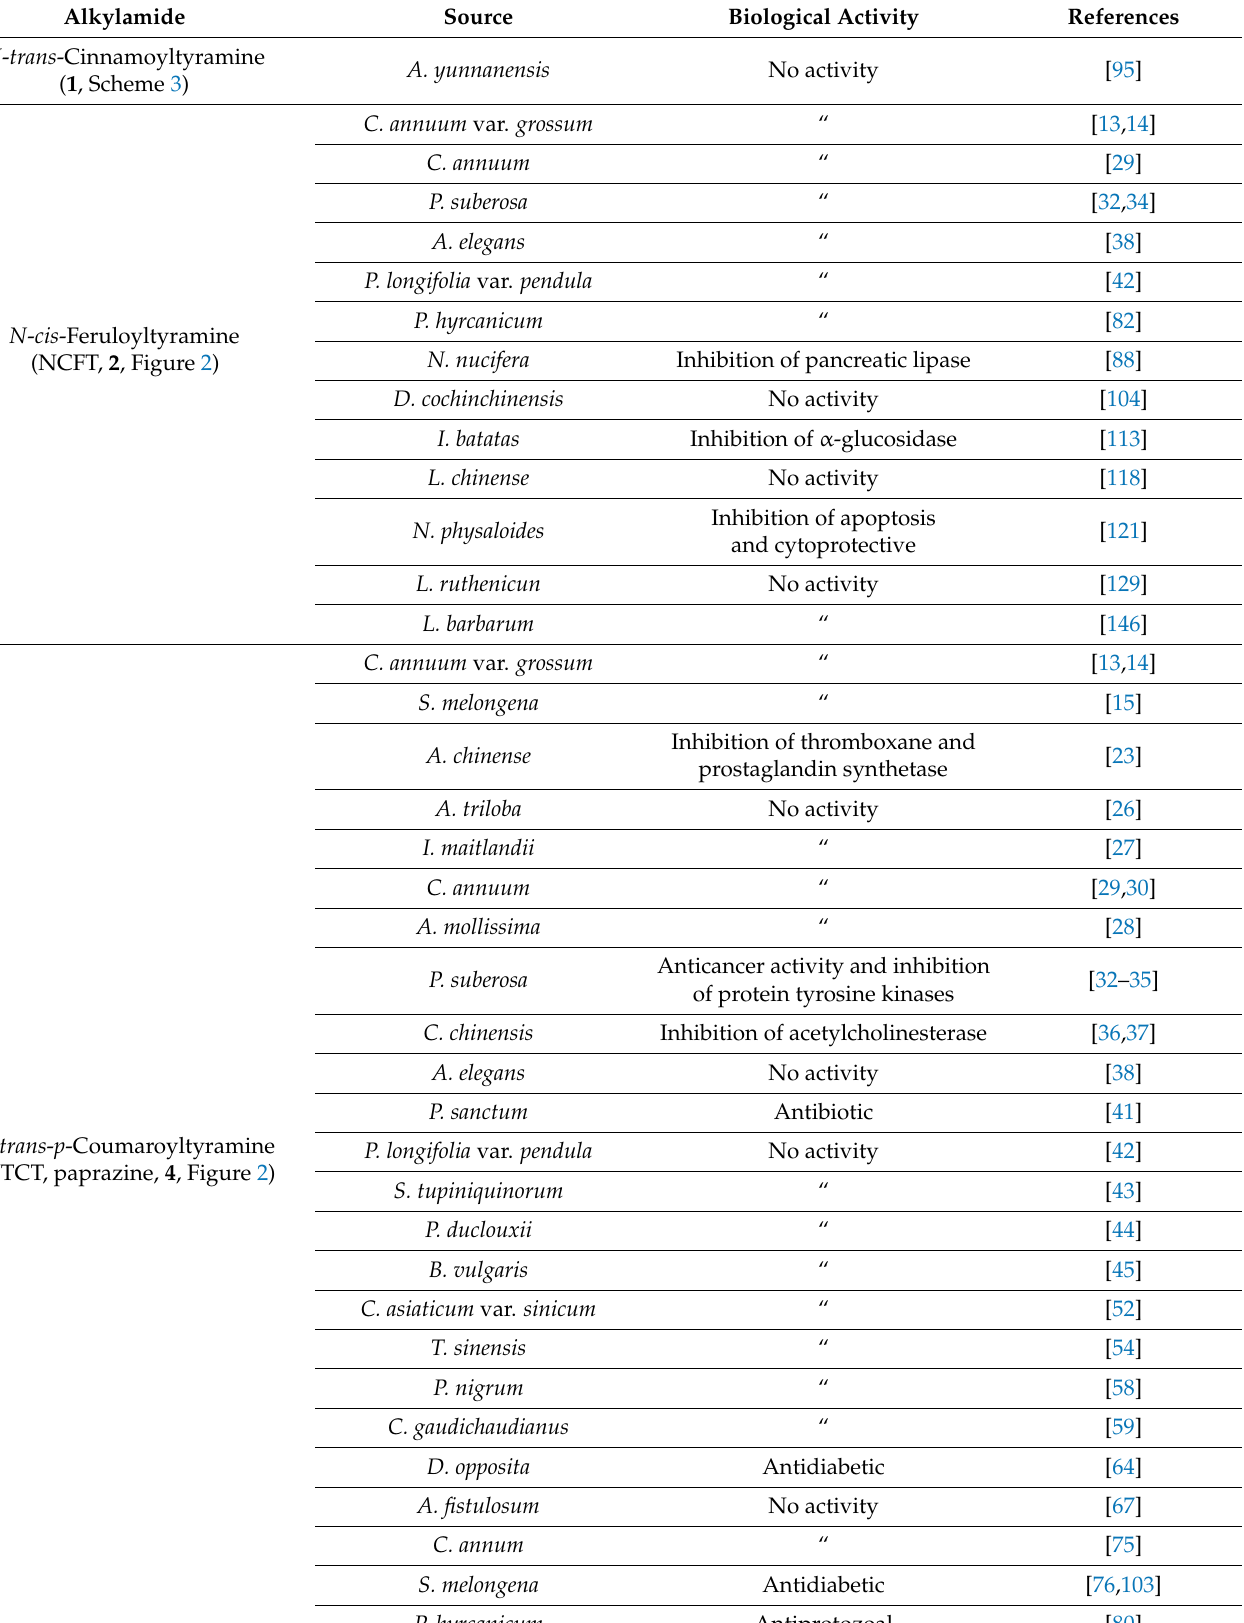
Table 1. Alkylamides, their sources and biological